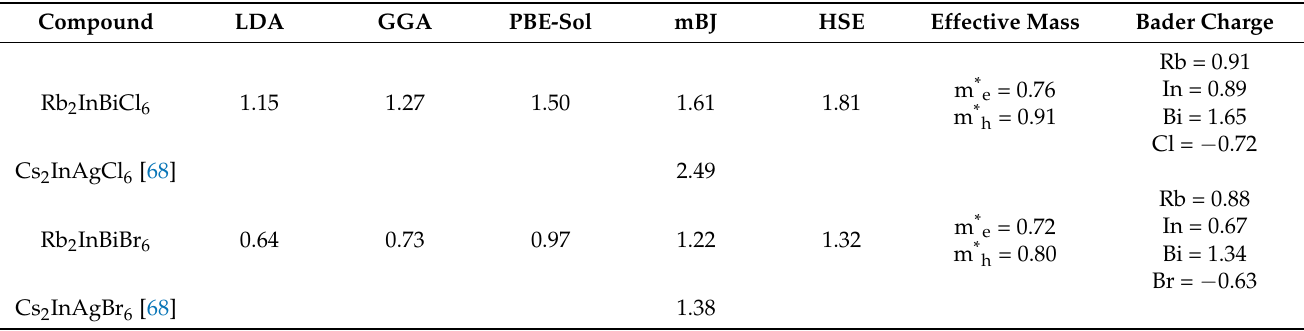
Table 3. Computed band gap using different exchange corelation functional, effective mass of electron (m e *) and holes (m h * ), Bader charges (using PBE-GGA approach) for Rb 2 InBiX 6 (X = Cl, Br) compound .